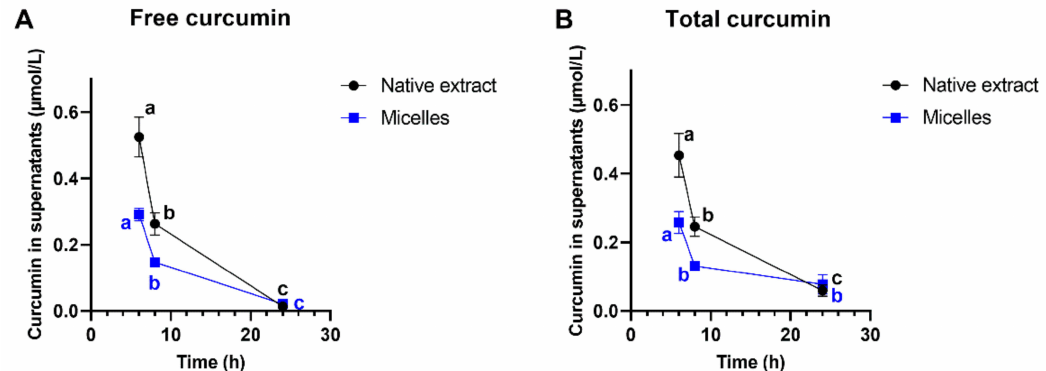
Figure 5. ( A ) Free and ( B ) total curcumin concentrations ( µ mol/L) in supernatants after pre-incubation of LS180 cells for 1 h, with native or micellar curcumin normalized to 60 µ mol/L, and further incubation for 6, 8, and 24 h, with curcumin-free cell culture medium. Data are presented as mean ± SEM. All experiments were conducted in biological triplicates ( n = 3) consisting of technical duplicates. Values within each formulation not sharing a common letter differ significantly at p < 0.05 (one-way ANOVA with Tukey’s post-hoc